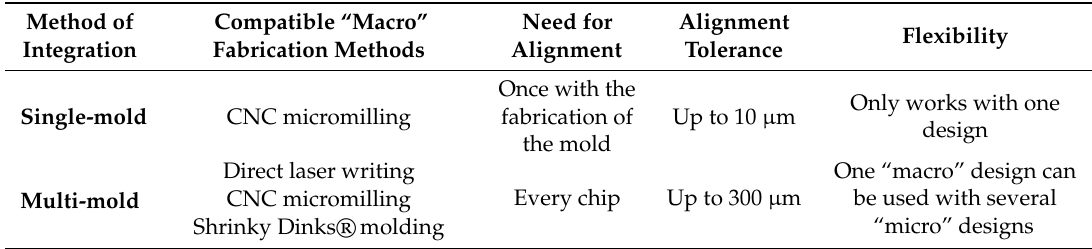
Table 2. Comparison between single- and multi-mold methods in terms of flexibility, need of alignment. and compatible fabrication